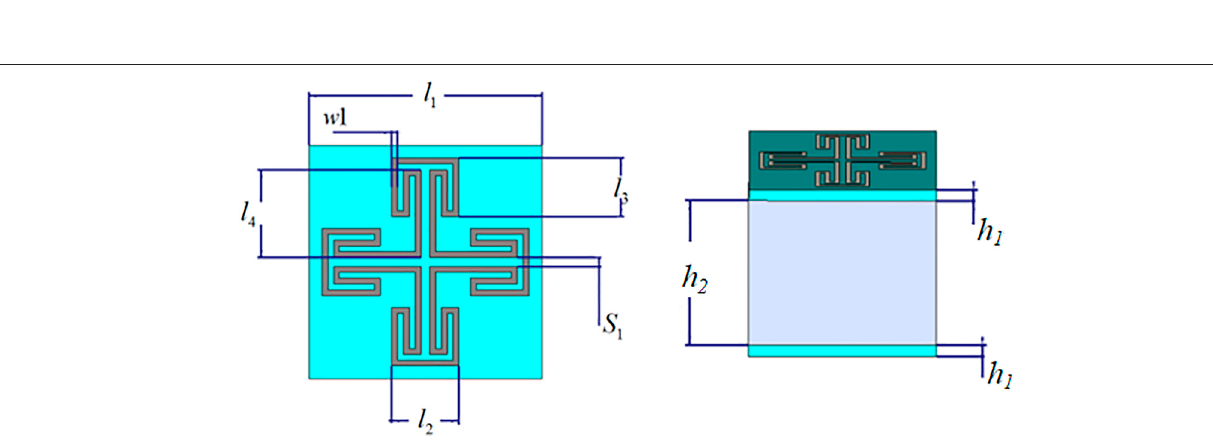
FIGURE 2 | Impedance range of Z A at the absorptive band with S 11 < − 10dB and S 21 < − 10 dB.